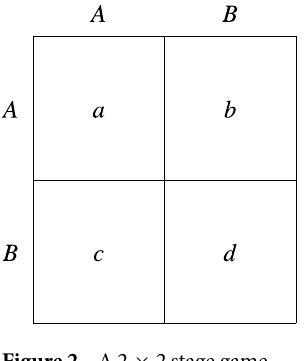
Figure 2. A 2 × 2 stage